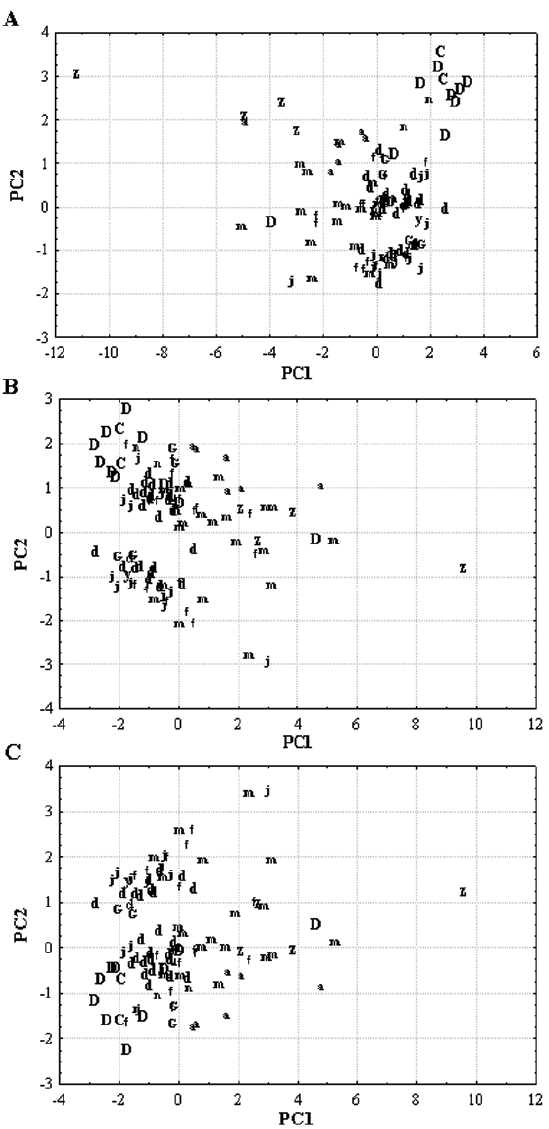
Figure 3. PC1-PC2 score plot: A-classical PCA; B-FPCA-1; C- of the initial ion concentrations to the variance of the four principal components as is shown in Table 6 and Fig. 4 . The columns corresponding to the first eigenvector obtained in all three cases indicate that the contribution to the first component is quite similar; negative values in the case of PCA and positive in other two cases. The